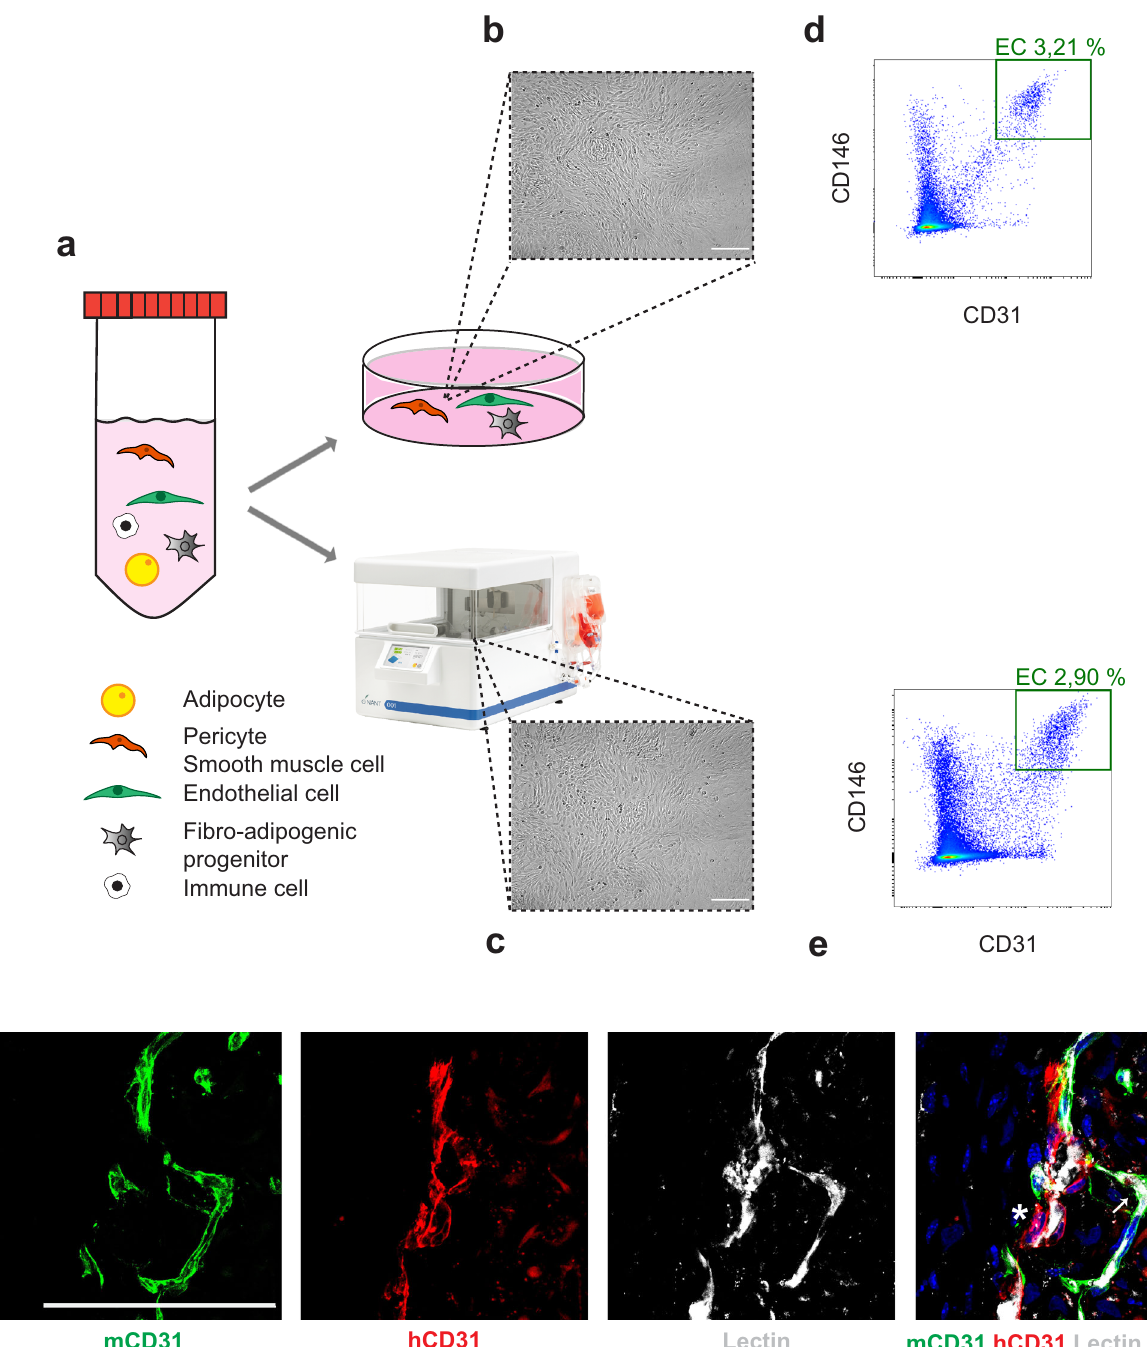
Fig. 7 Expansion of diabetic, human SVF using an automated bioreactor. a Schematic representation of the different cell types composing the human SVF. b Bright- fi eld microscopy of SVF cells expanded for 7 days in a standard culture dish. c Bright- fi eld microscopy of SVF cells expanded for 7 days using a bioreactor. d Flow cytometry pro fi le of cells expanded for 7 days in a standard culture dish. e Flow cytometry pro fi le of cells expanded for 7 days using a bioreactor. The number of ECs is comparable to panel d . f Representative images of the vasculature formed by diabetic, human SVF at 7 days after its implantation in NSG mice, upon perfusion with biotinylated lectin (white). Lectin signal is localized within both donor (red, asterisk) and host (green, arrow) vessels. Scale bar in ( b , c , f ) is 100 μ The adipose tissue was rinsed with calcium- and bicarbonate- free Hank ’ s solution with HEPES (CBFHH) and minced using fi ne scissors until the tissue suspension appeared homogeneous. The tissue was transferred in gentleMACS C Tubes (Miltenyi Biotec, 130-093-237, 130-096-334) containing a pre-warmed digestion solution composed of 1 mg/mL Collagenase NB4 Standard Grade